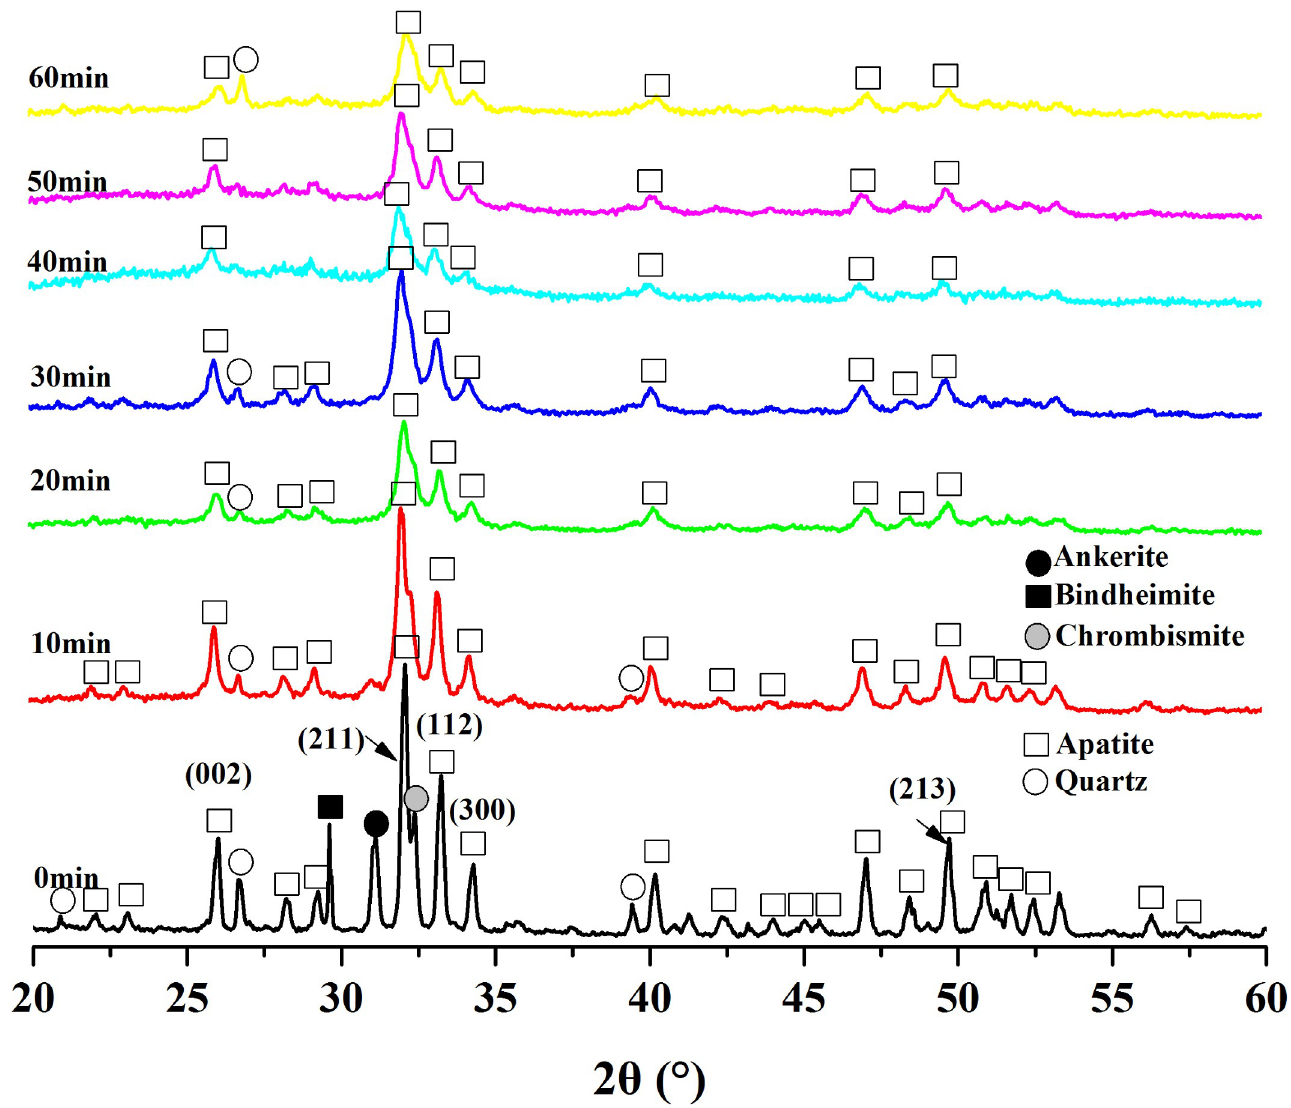
Fig 4. XRD patterns of phosphorite at different milling